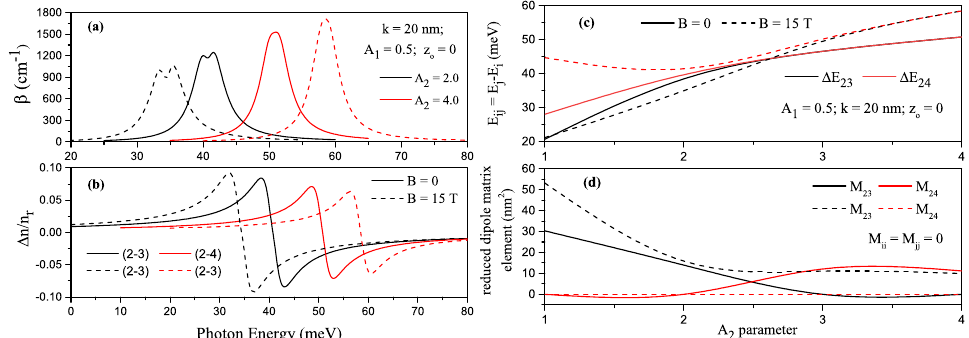
Figure 5. For some transitions between the energy levels in harmonic-Gaussian symmetric DQW ( z 0 = 0) with A 1 = 0.5, the variation of total absorption coefficients as a function of the incident photon energy ( a ) and the variation of total refractive index as a function of the incident photon energy ( b ). Here, black (red) lines are for A 2 = 2.0 ( A 2 = 4.0), according to parameter- A 2 . The variation of the energy difference between related levels ( c ) and the variation of reduced dipole matrix element ( d ), where black/red lines are for (2–3)/(2–4) transitions. Solid (dashed) lines are for B = 0 ( B =